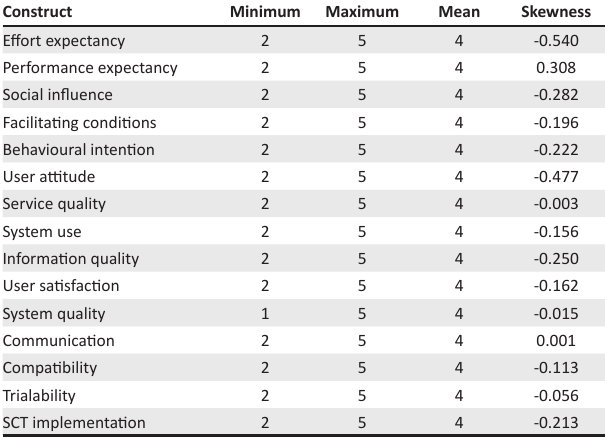
TABLE 2: Construct descriptive